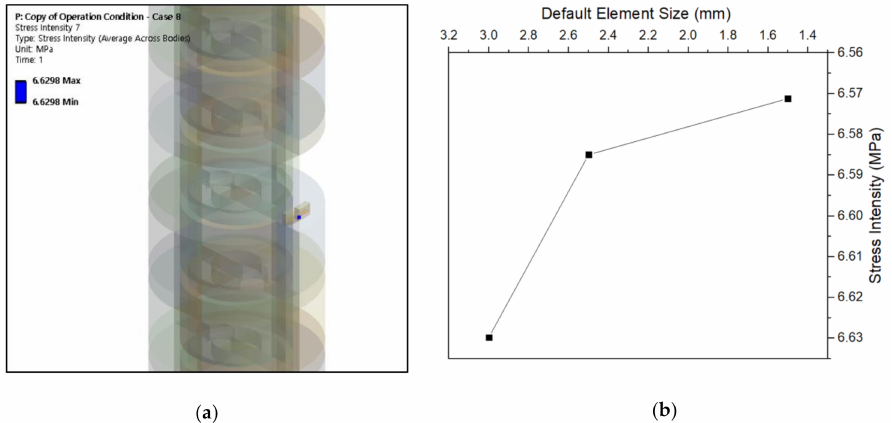
Figure 10. Results of the grid sensitivity study for the structural analysis: ( a ) location for the assessment of stress intensity and ( b ) default element size versus stress intensity.